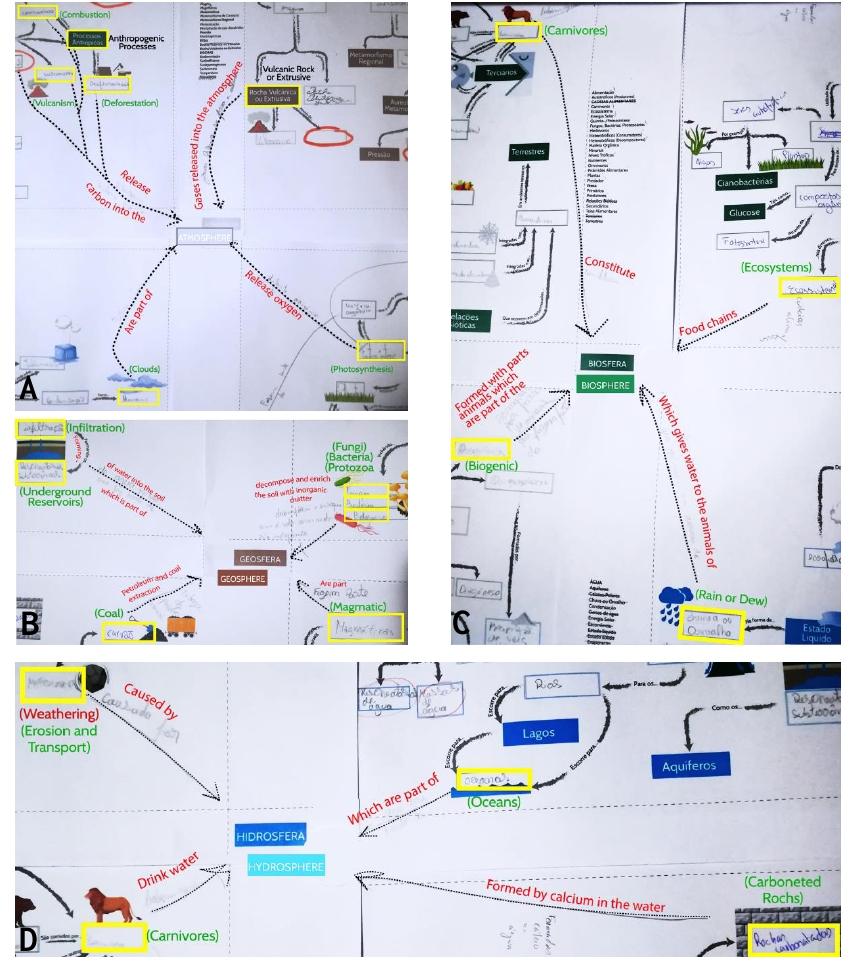
Figure 4. Examples of the most complete relations established between cycles and each one of the earth subsystems (( A )—Atmosphere, ( B )—Geosphere, ( C )—Biosphere, ( D )—Hydrosphere). Terms in red were incorrectly placed (*). Terms in green are correctly placed. Inside the yellow boxes are the terms used to make